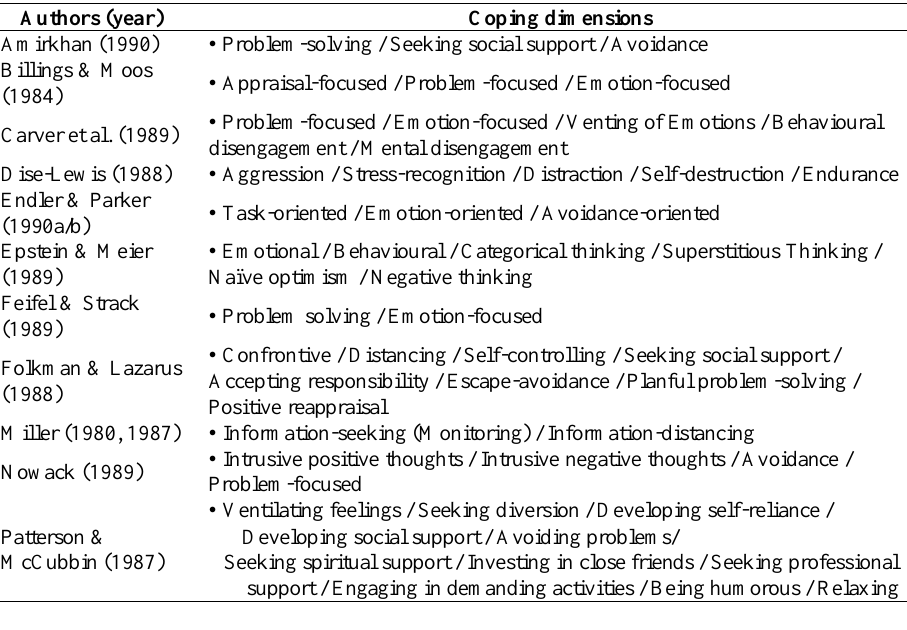
Summary of coping dimensions evaluated in developed stress-coping